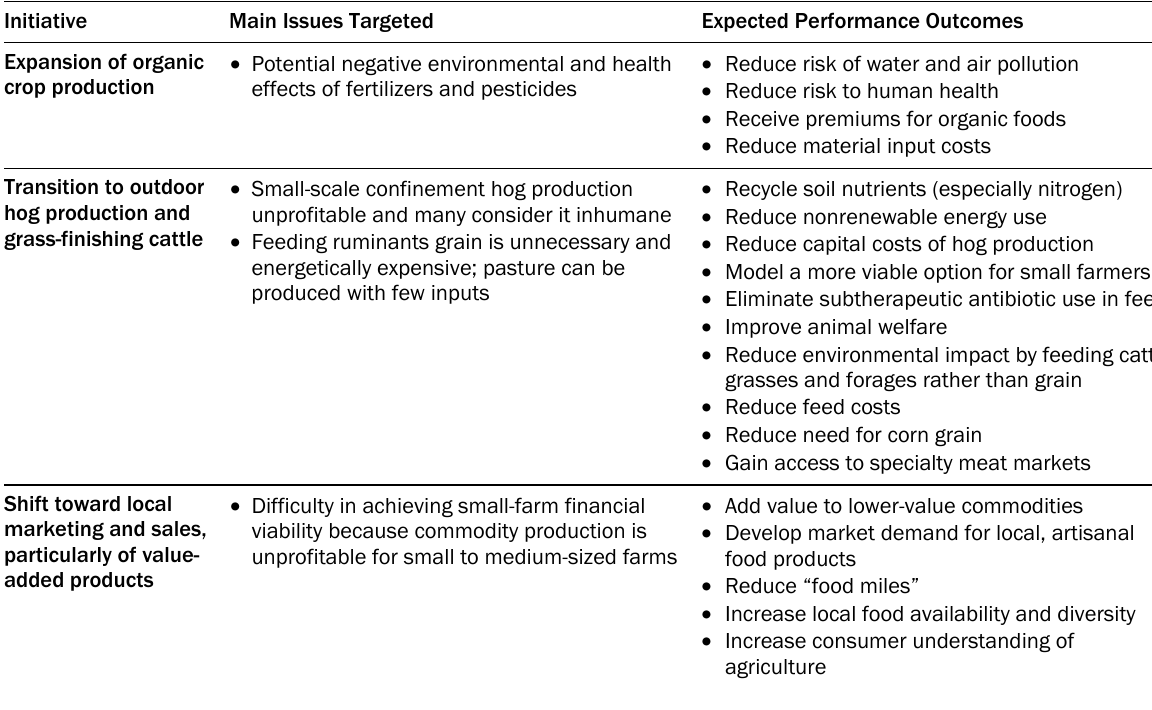
Table 1. Initiatives Implemented on the Berea College Farm to Address Sustainability